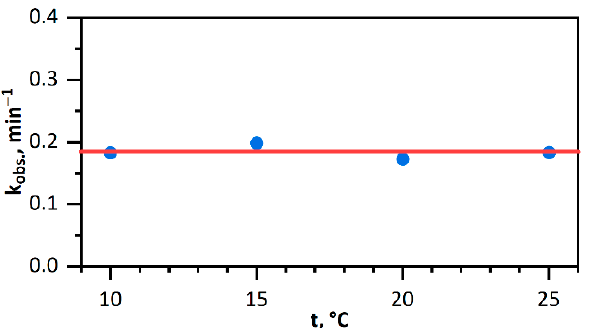
Figure 7. Observed rate constant of Fe(CN) 63 − reduction with hydrogen vs. temperature. Solution: [ Fe(CN) 63 – ] = 1.00 mM; [ Pd 0 ] = 0.020 mM, [H 2 ] = 0.80 mM (p(H 2 ) = 1.025 atm).